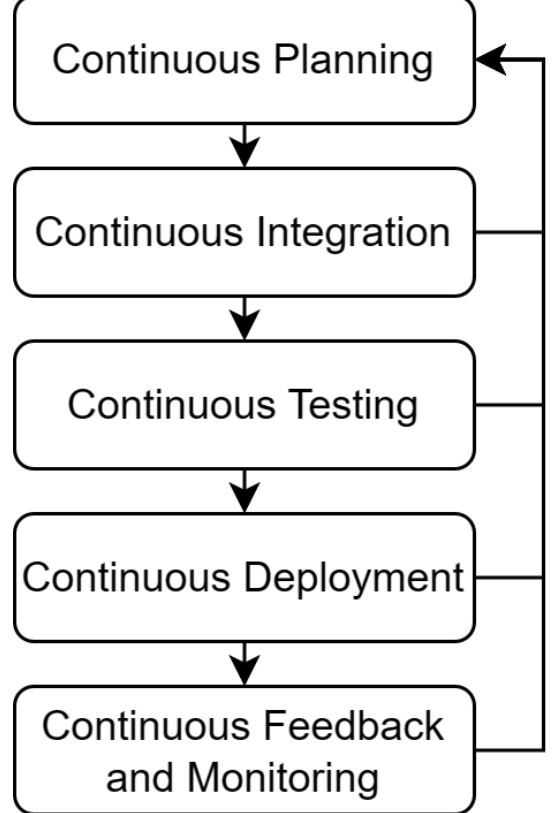
Figure 1. DevOps